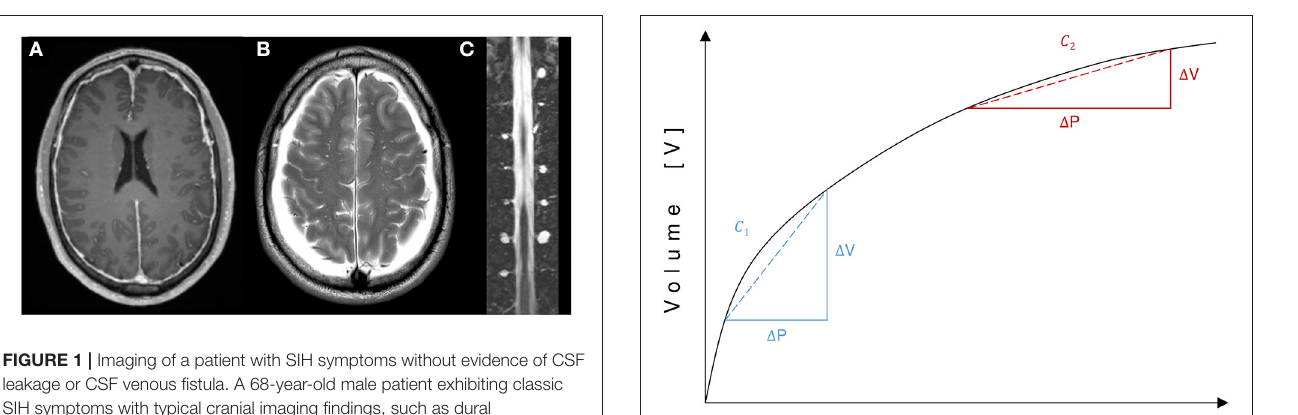
to positive pressure values, is located in the upper cervical